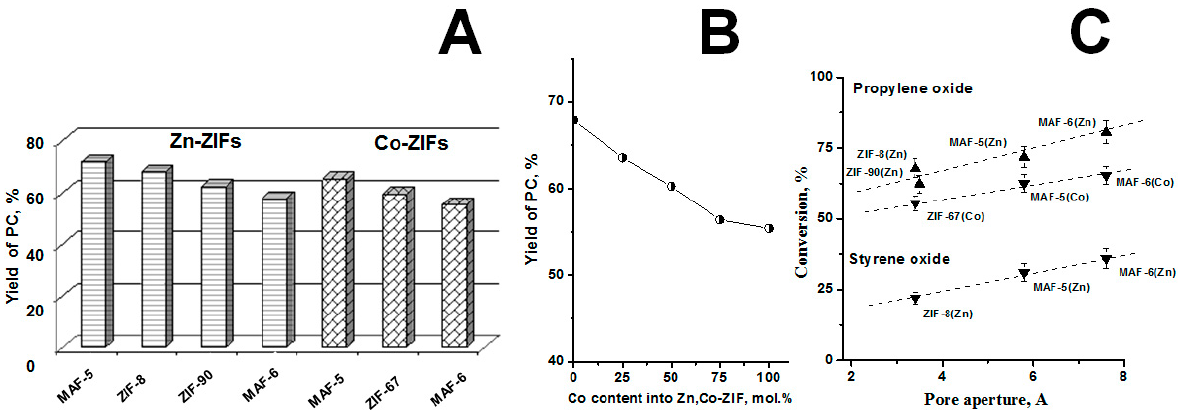
Figure 5. ( A ) The catalytic properties of ZIFs in the synthesis of propylene carbonate from CO 2 and propylene oxide. ( B ) The correlation between the amount of Co in the framework of mixed Zn,Co ‐ ZIF and the yield of PC. ( C ) The correlation between the yield of PC and the pore size (d p ) of ZIFs. (Experimental conditions: 24 mmol of propylene oxide, 0.8 MPa of CO 2 (at room temperature), 50 mg of catalyst, 50 mg of [n ‐ Bu 4 N]Br, 353 K, 5 h). Firstly, this reduction is attributed to the difference in the accessibility of active sites to reagents. This difference results from the slight differences in their frameworks. As per [29], ZIF ‐ 8 possesses a larger cavity (11.6 Å) and pore aperture (3.4 Å) than ZIF ‐ 67 (11.4 Å and 3.3 Å, respectively). Another reason may be the difference in microporosity